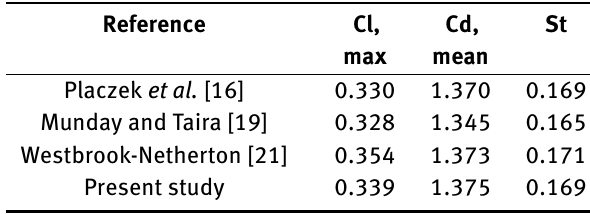
Table 1: Results comparison of a fixed cylinder at Re = 100